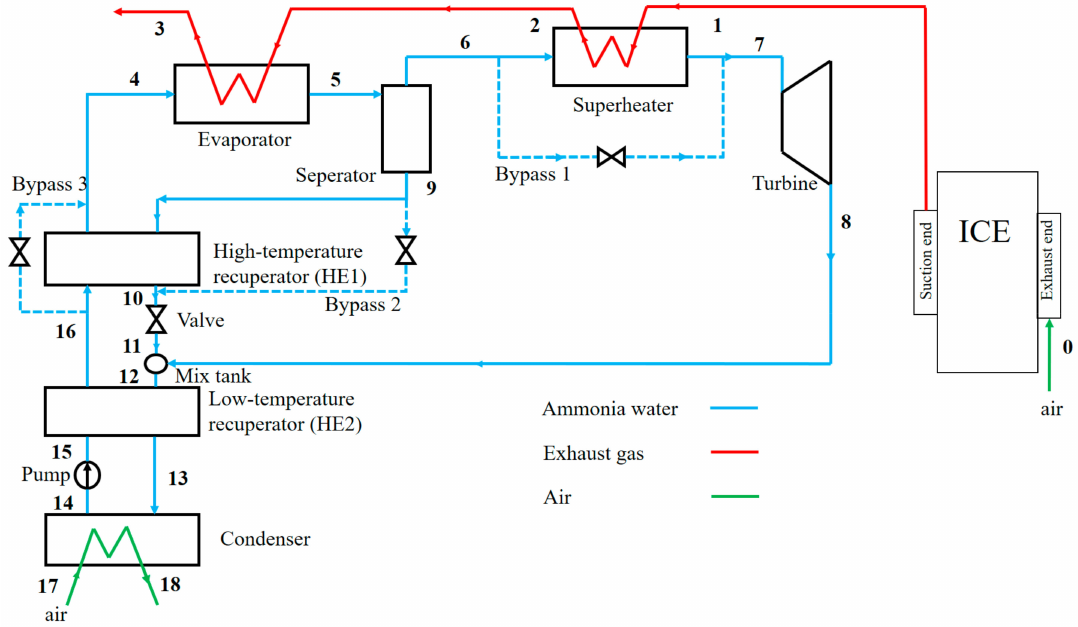
Figure 1. Schematic of bottoming KC with a superheater for ICE waste heat recovery.